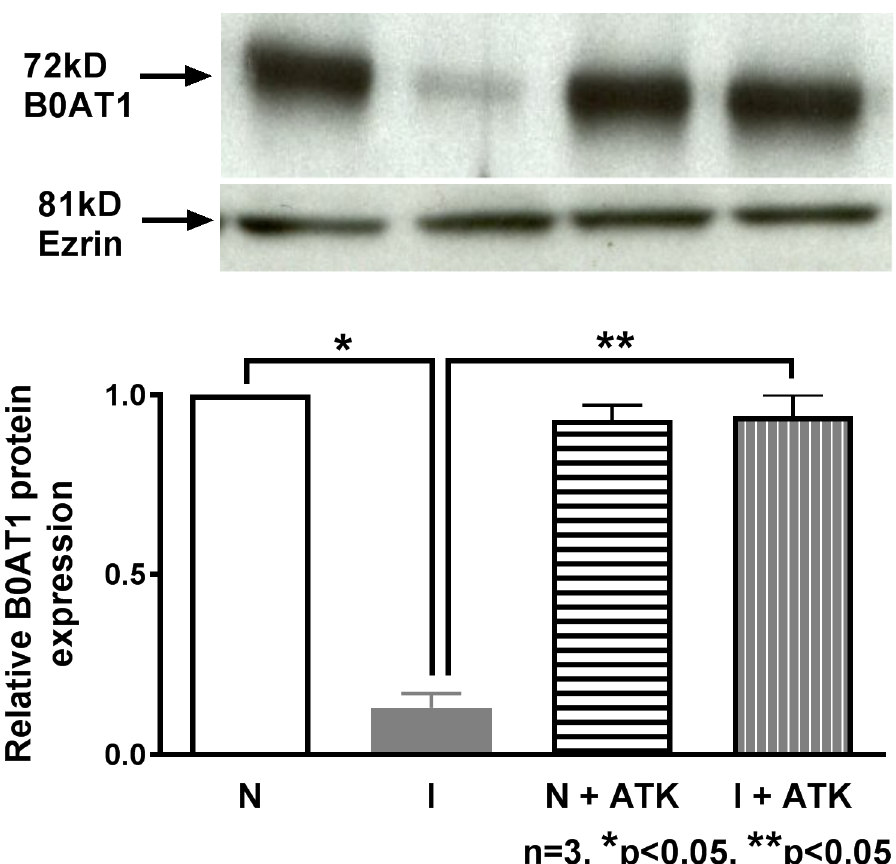
Fig 4. B0AT1 protein expression in AKT treated villus cell BBM. A representative Western blot of BBM B0AT1 protein levels is shown in the upper panel. In the lower panel densitometric quantitation is shown. The relative protein expression of B0AT1 that was significantly reduced during chronic intestinal inflammation was restored to near- normal levels by AKT treatment and B0AT1 levels were unaffected in the normal intestine.